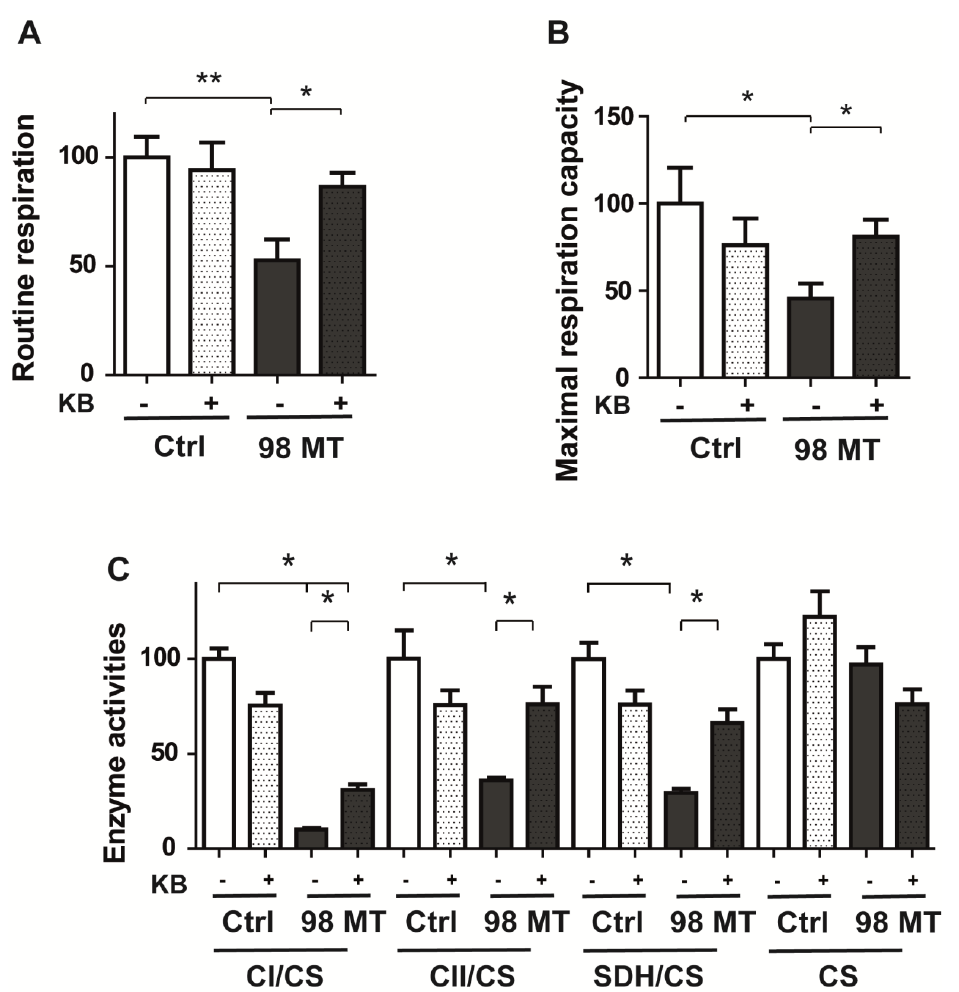
Figure 5. Treatment with ketone bodies improves mitochondrial respiration and enzyme activities in MELAS cells. ( A ) Oxygraphic measurements of routine ( B ) and maximal respiration capacity in Ctrl and 98% MT cells, treated with or without KB for 48 h. ( C ) Enzyme activities of mitochondrial complex I, II, and SDH, relative to citrate synthase (CS) in control and 98% MT cells, treated for 48 h with or without KB. Results are presented as the mean ± SEM, relative to Ctrl cells, of at least 4 independent experiments. Statistical differences between 98% MT and Ctrl cells are indicated with an asterisk (* p < 0.05; ** p < 0.01).